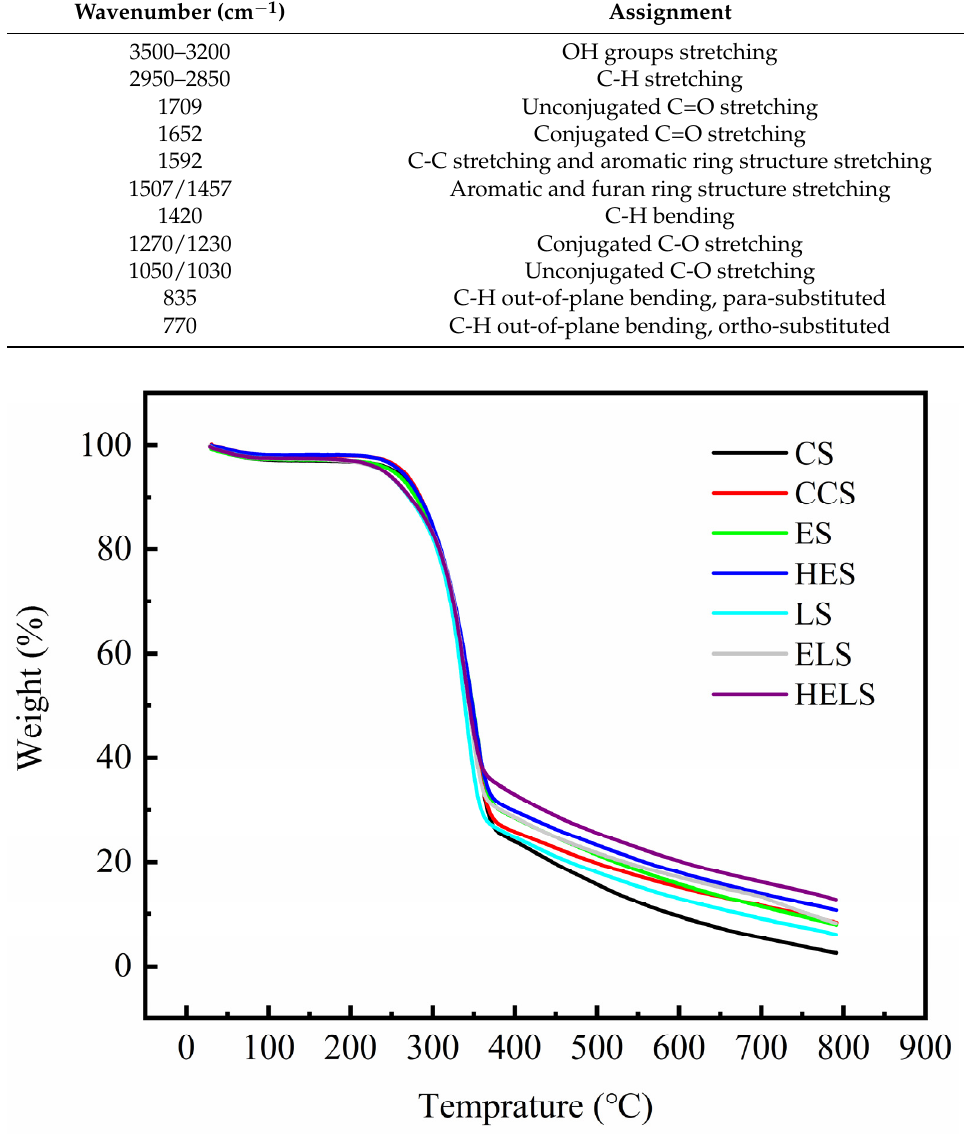
Figure 8. Thermogravimetric analysis of MFP. The temperature was increased from 30 to 795 °C at a heating rate of 10 °C/min under nitrogen atmosphere (30